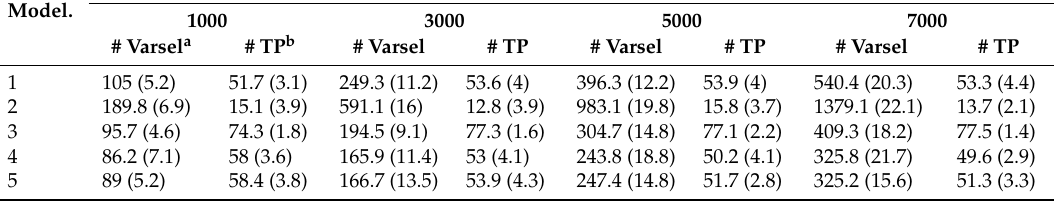
Table 4. Influence of inter-individual variability on variable selection performance of five models on simulated